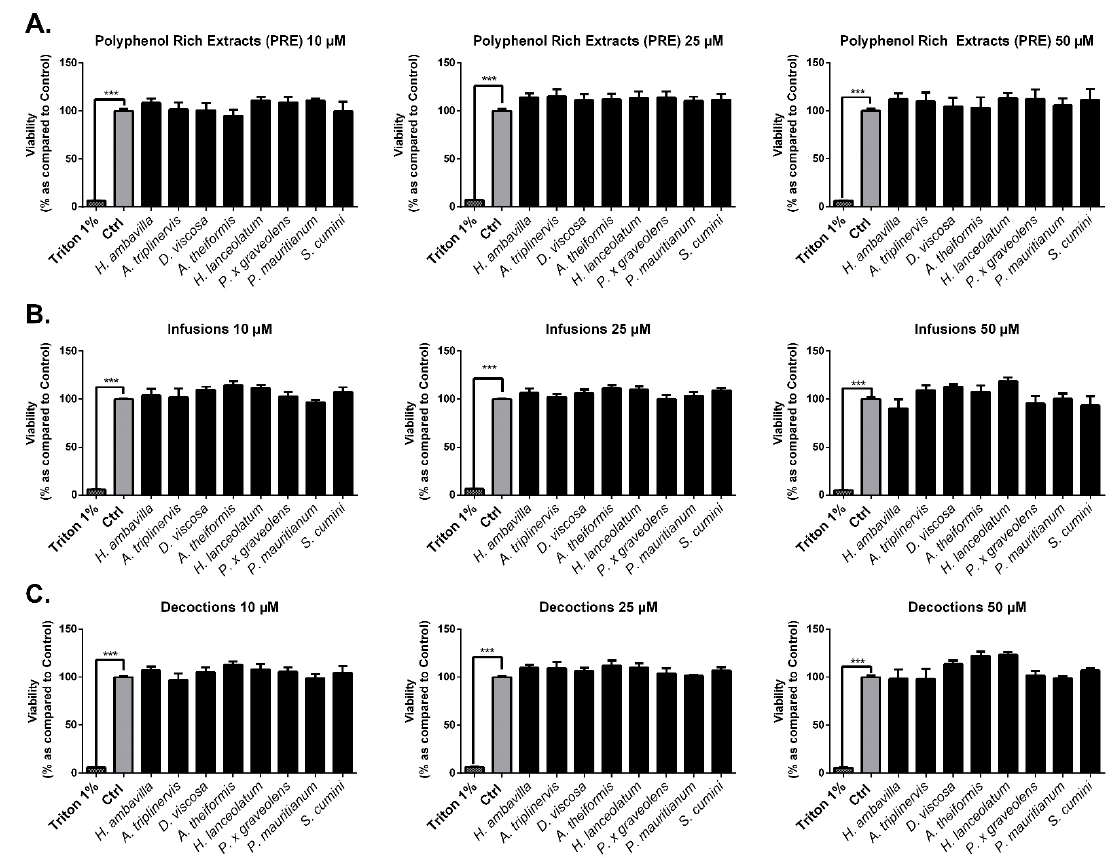
Figure 6. E ff ects of medicinal plant preparations on 3T3-L1 viability and proliferation. 3T3-L1 preadipocytes were incubated with di ff erent medicinal plant extracts: PRE ( A ), infusions ( B ) and decoctions ( C ). Viability (% Control) was assessed by the neutral red method. Triton X100 (1%) was used to induce cell necrosis. Results are presented as means ± SEM of three independent experiments *** p < 0.005 as compared to control (Ctrl).